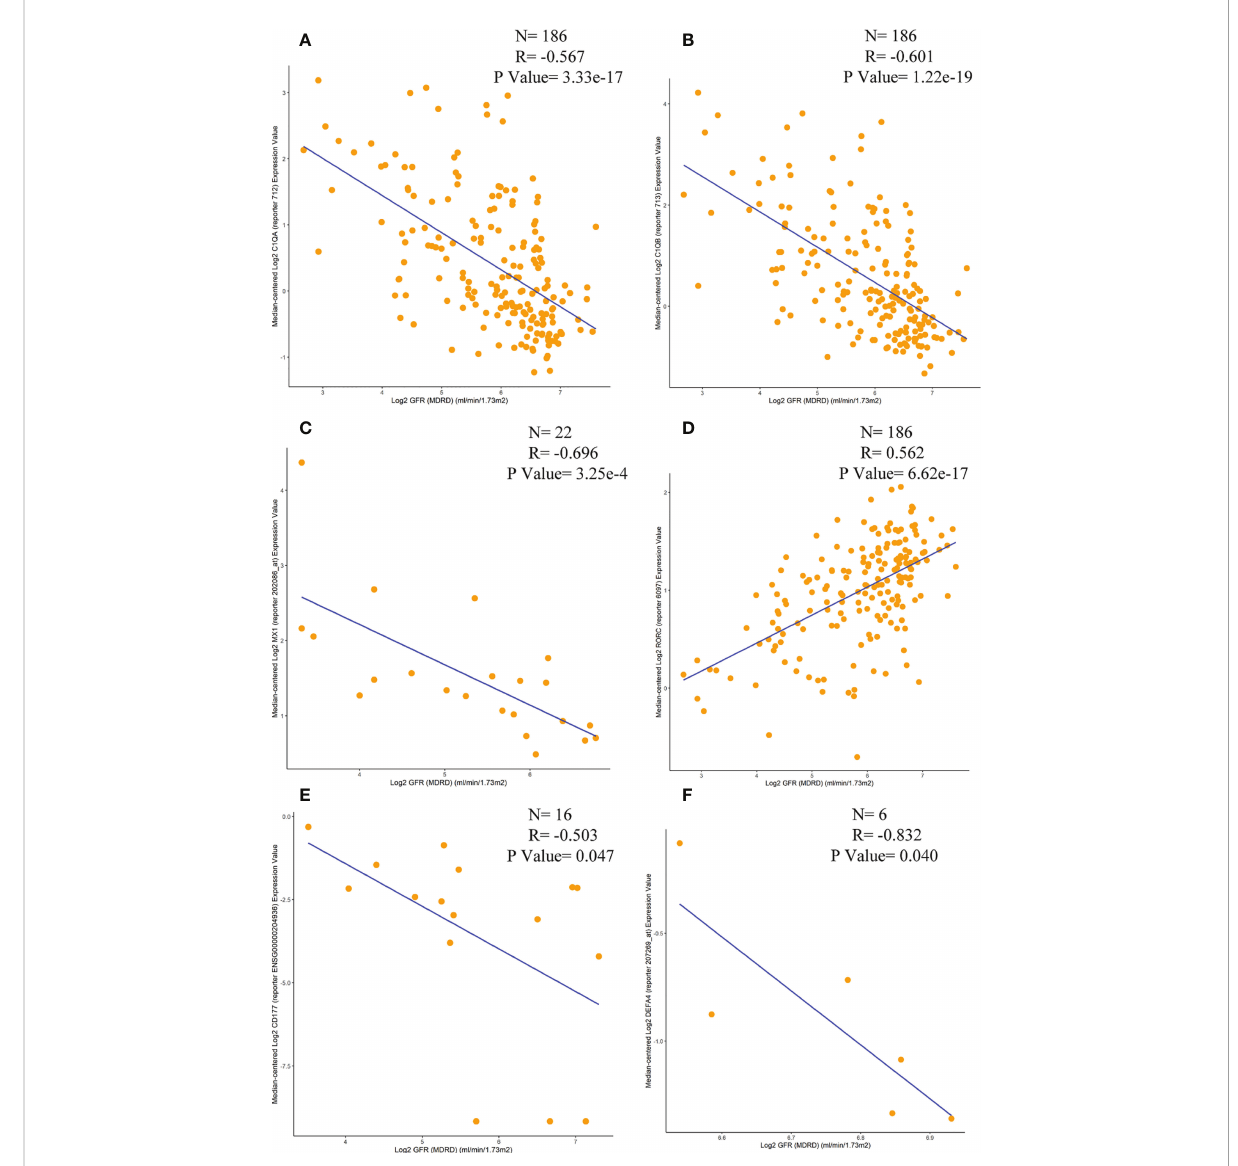
FIGURE 11 Correlation analysis of the expression levels of C1QA, C1QB, MX1, RORC, CD177 and DEFA4 with GFR. (A) C1QA, (B) C1QB, (C) MX1, (D) RORC, (E) CD177, (F)